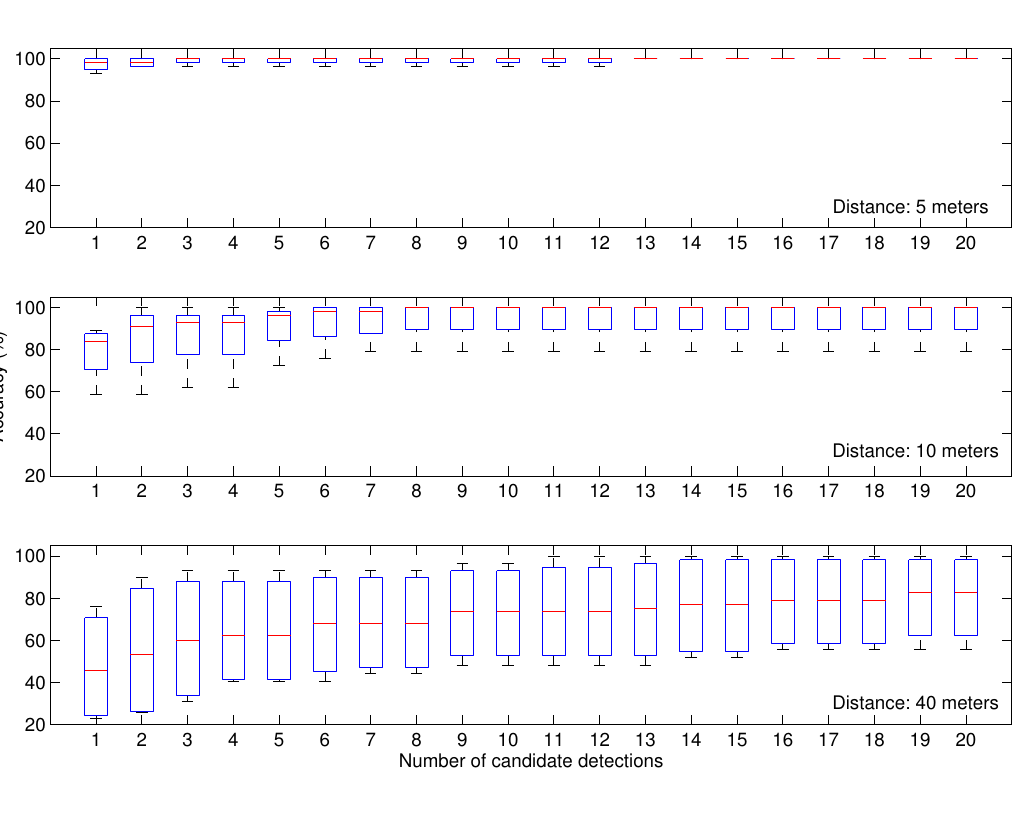
Figure 6. Percentage of correct detections of order n of the mCHT-based